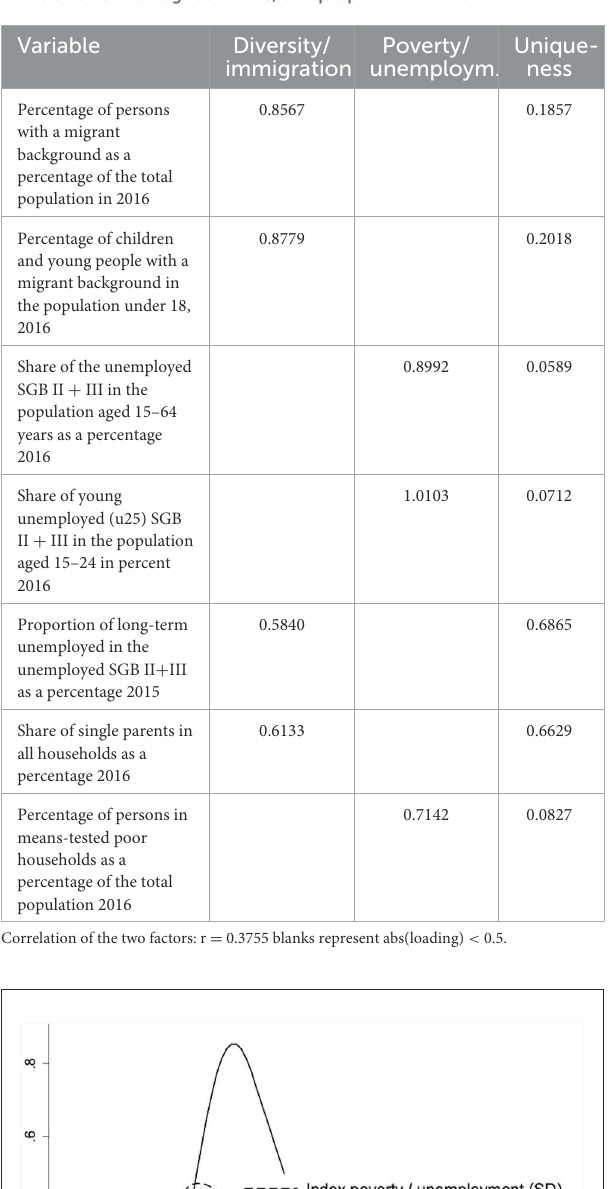
TABLE 3 Factorial ecology of immigration and poverty/unemployment, N = 405 small scale neighborhoods, oblique promax rotation.